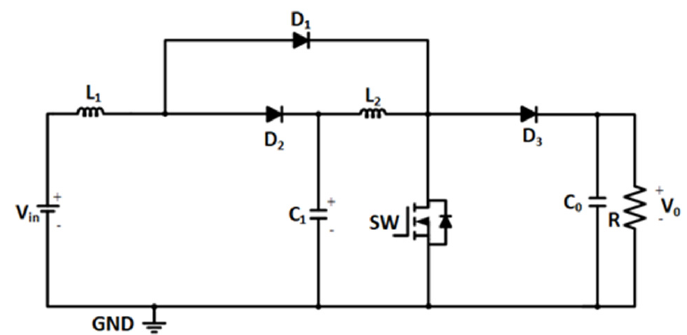
Figure 2. Circuit configuration of Conventional QBC.